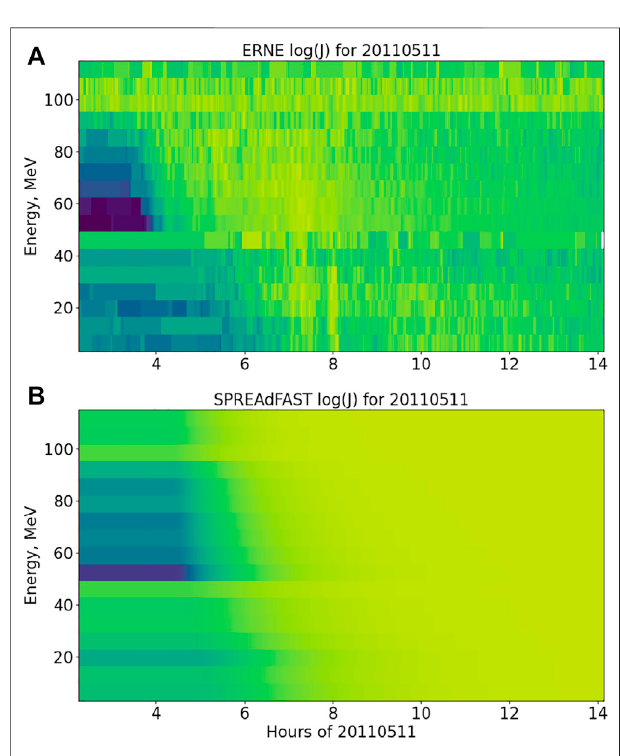
FIGURE 11 | Dynamic spectra of the differential proton fl uxes of the ERNE observations (A) and the EPREM simulation (B) for the 110511 event. Time on the x -axis is in hours from the start of May 11,